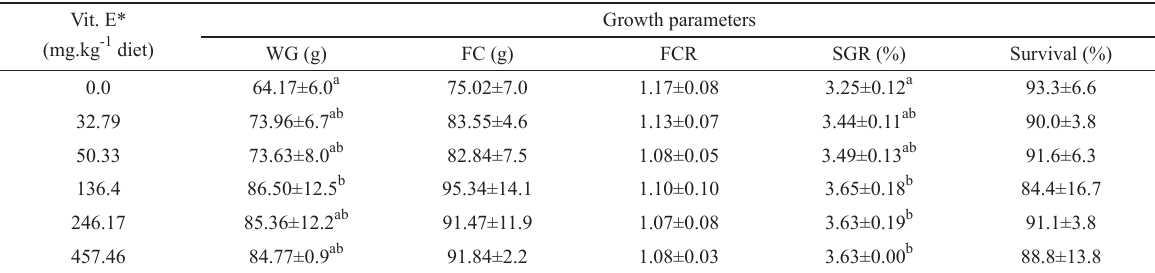
Means and standard deviation (SD) of individual weight gain (WG), feed consumption (FC), feed conversion rate (FCR), specific growth